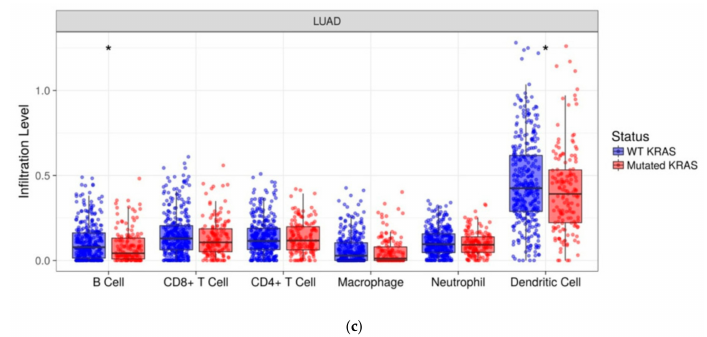
Figure 4. TIMER deconvolution from 95-gene expression matrix of real-life cohort stratifying for ( a ) KRAS mutational status and ( b ) cluster assignment; ( c ) TIMER estimation of TCGA-LUAD dataset. Then, the amount of B lymphocyte infiltration has been evaluated in situ through immunohistochemistry in an independent cohort including 15 cases. It was observed that 5 / 6 (83%) of KRAS WT cases have B cell infiltration (20%–70% of total infiltration); whilst 5 / 9 KRAS (55%) mutated showed no B cell infiltration (Figure 5).